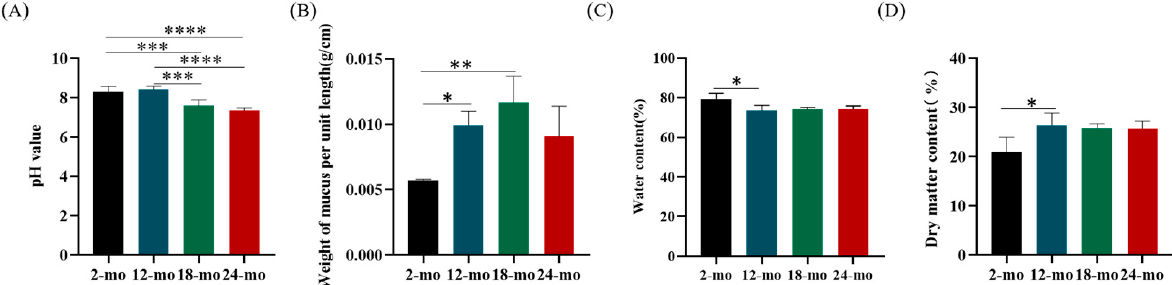
Figure 3. Physiological characteristics of colonic mucus in aging mice. The pH ( A ), mucus weight per unit length ( B ), water content ( C ), and dry matter content ( D ) of colonic mucus in aging mice were determined. Data were presented as mean ± SD. Data were statistically analyzed using one-way ANOVA with Tukey’s post hoc test. Asterisk indicates significant difference, * p < 0.05, ** p < 0.01, *** p < 0.001, **** p < 0.0001, n = 3 per group.